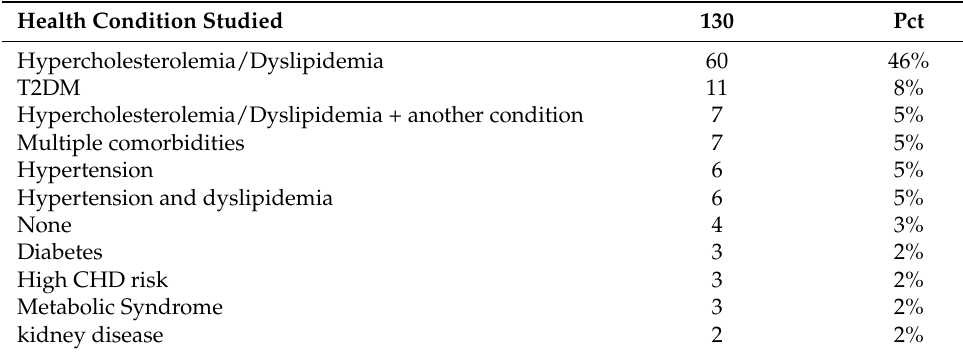
Table 5. All primary studies by health condition